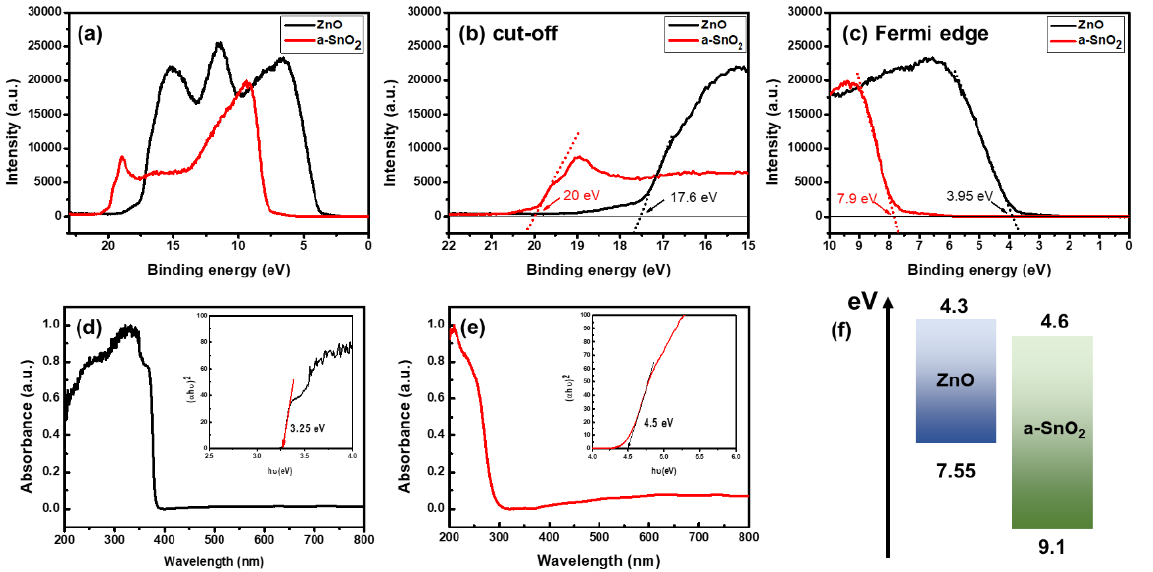
Figure 7. ( a ) UPS spectra of ZnO and SnO 2 , ( b ) the cut-off energy region, and ( c ) the Fermi edge region of ZnO and SnO 2. UV-Vis measurements of ( d ) ZnO NRs and ( e ) SnO 2 NRs. The insets of ( d ) and ( e ) show the bandgaps of ZnO NRs and SnO 2 NRs. ( f ) Energy band diagram of ZnO NRs and SnO 2 NRs.